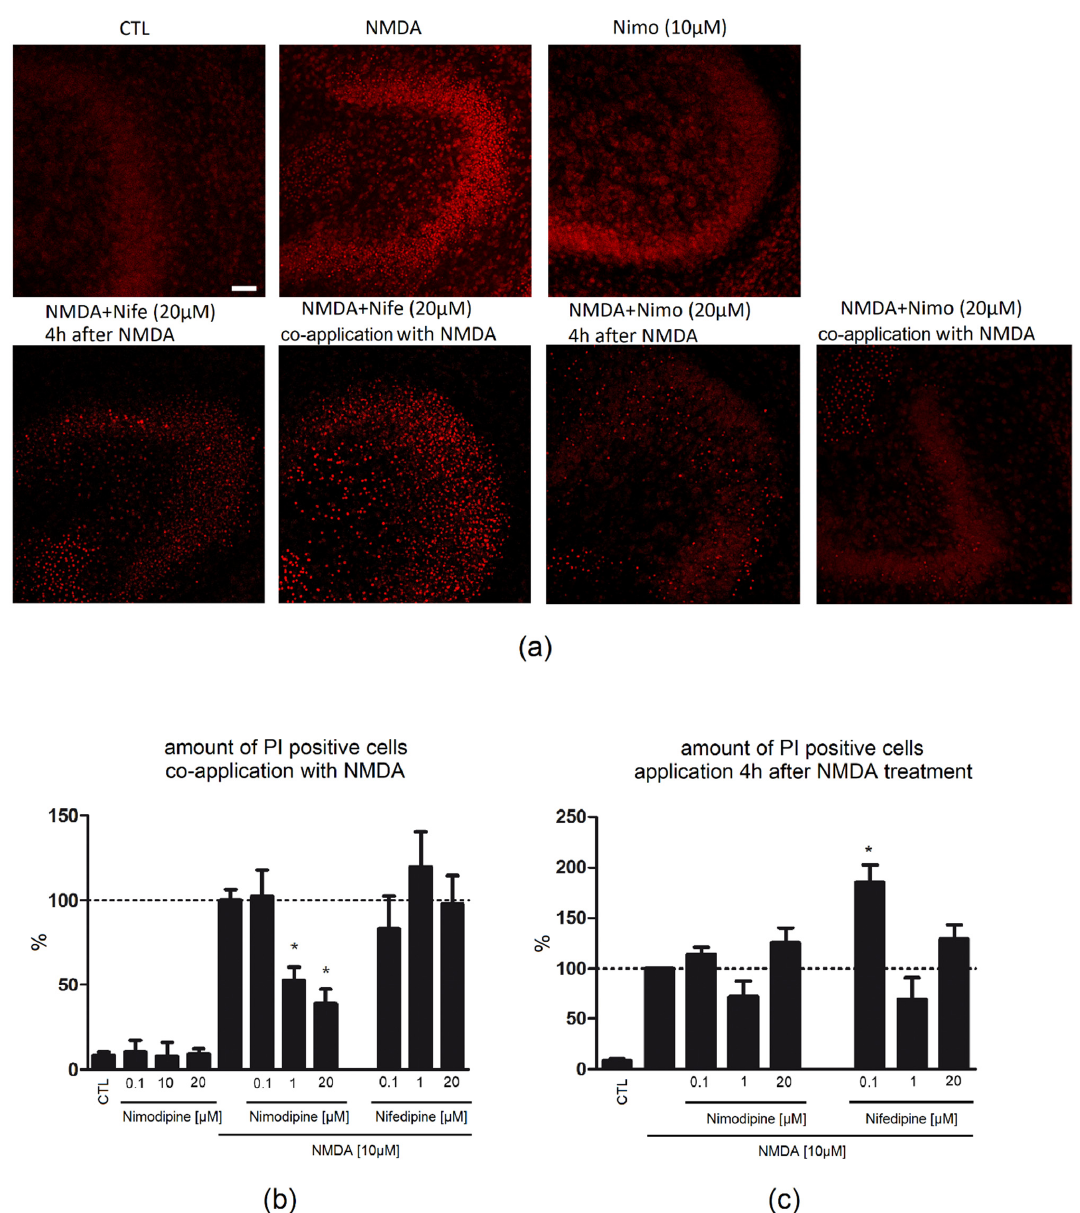
82.29%/GCL; 20 μ M: 107.5%/GCL) or nifedipine (0.1 μ M: 78.76%/GCL; 1 μ M: 114.1%/GCL; 20 μ M: 102%/GCL) were applied 4 h after beginning of the lesion with NMDA (Figure 2).